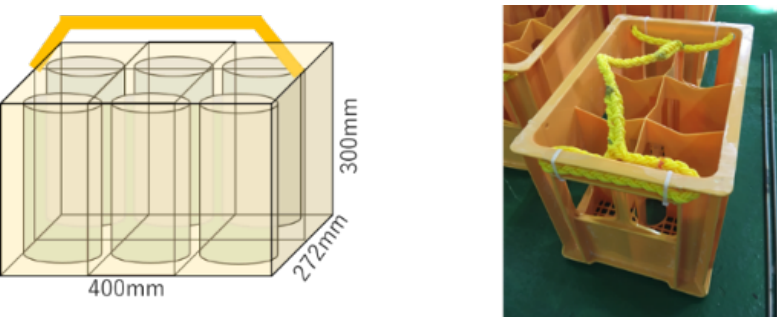
Figure 3. Concept (left) and image (right) of the plastic basket the for concrete specimen.